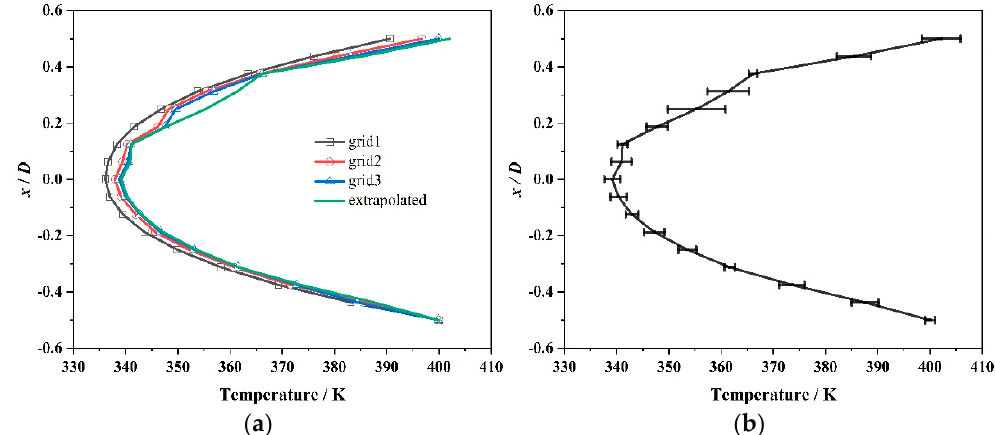
Figure 4. Grid independence of the fin structure including ( a ) outlet temperature under three sets of grids; ( b ) discretization error.